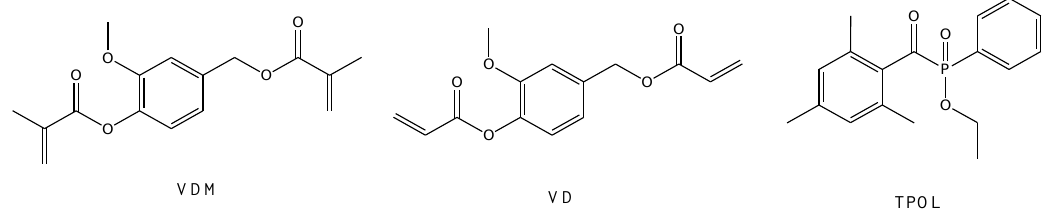
Figure 1. Chemical structures of vanillin dimethacrylate (VDM), vanillin diacrylate (VD), and ethyl(2,4,6-trimethylbenzoyl)phenylphosphinate (TPOL).